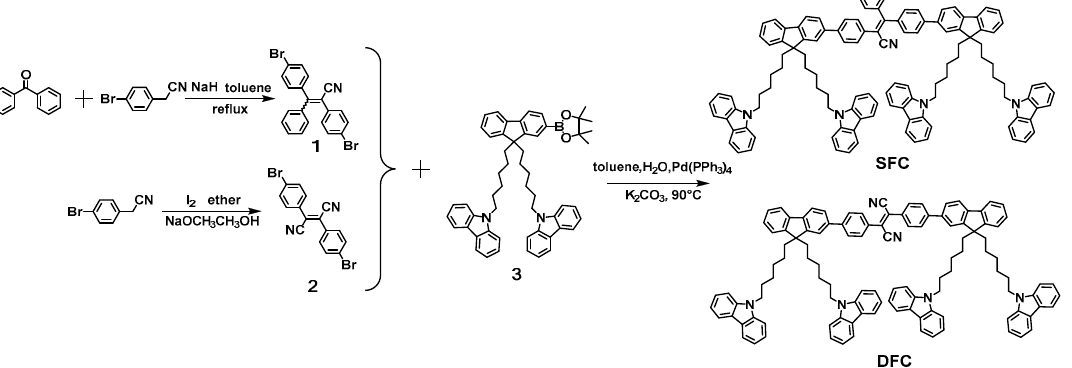
Table 1. Thermal, photophysical, and electrochemical data of SFC, trans -DFC, and cis -DFC.